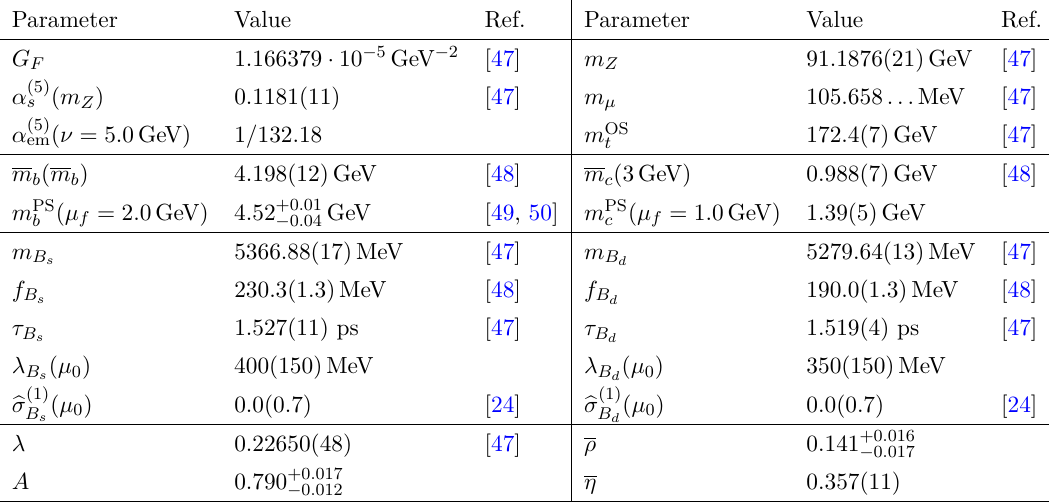
Table 1 . Numerical input values for parameters. The values of the bottom- and charm-quark masses in the MS scheme are averages of N f = 2 + 1 + 1 lattice determinations from the FLAG group from [51–55] and [51, 55–58]. The B q -meson decay constants f B are averages from the q FLAG group for N f = 2 + 1 + 1 from [4, 53, 59, 60]. The combinations of CKM parameters have been determined from [61] for PDG 2020, which are very similar to [62]. The reference scale for the B -meson LCDA parameters λ B , σ (1) is µ 0 = 1 b B q q